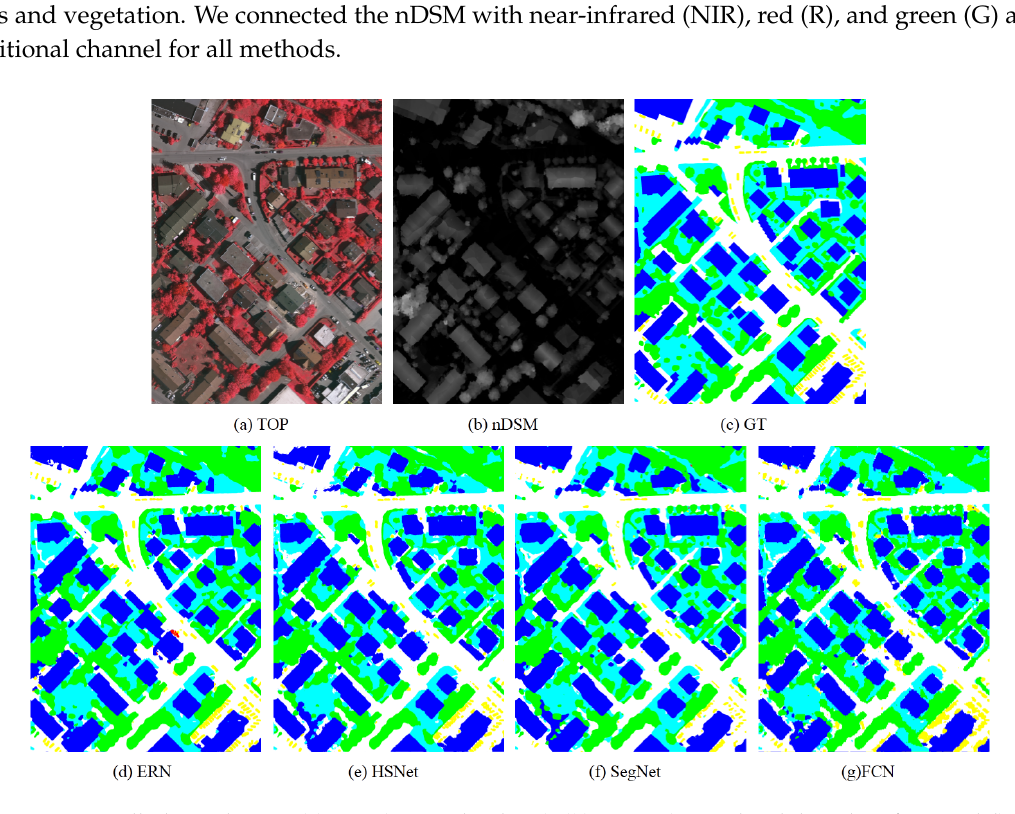
Figure 8. Full tile prediction. ( a ) TOP (true orthophoto); ( b ) nDSM (normalized digital surface model); ( c ) GT (ground truth). ( d – g ) the inference results from ERN, HSNet [24], SegNet [19], and FCN [17], respectively; white: impervious surfaces; blue: buildings; cyan: low vegetation; green: trees; yellow: cars; red: